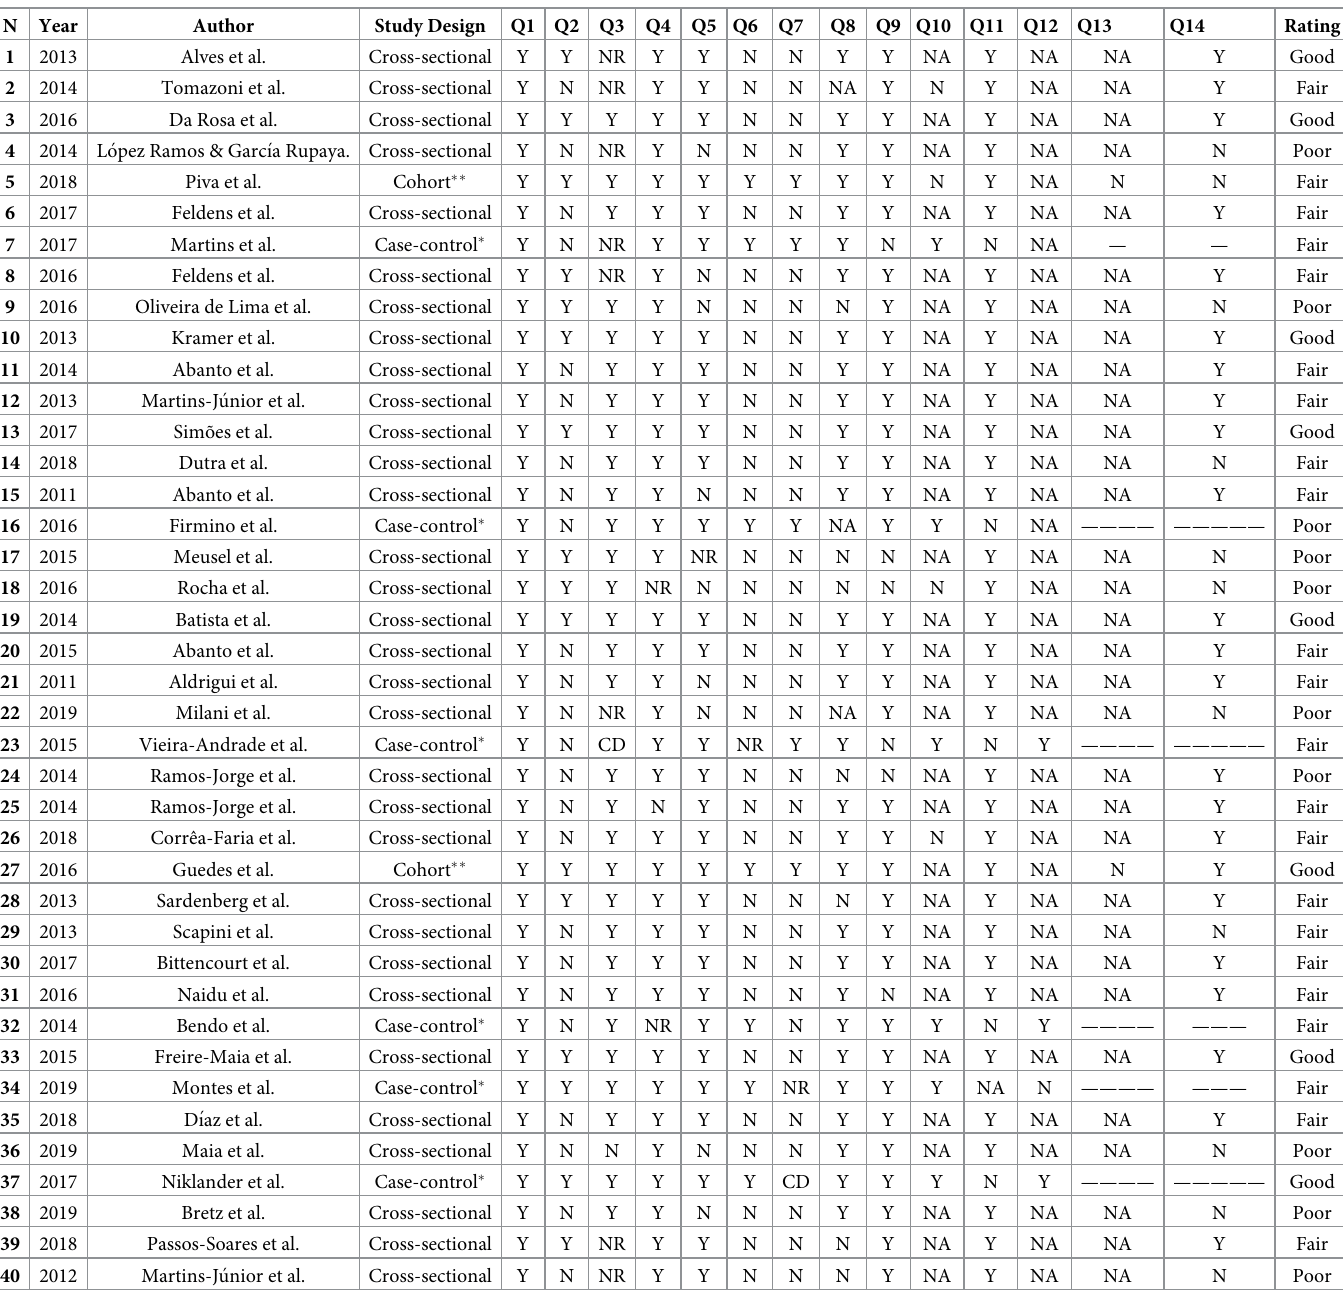
Table 3. Quality assessment of the studies